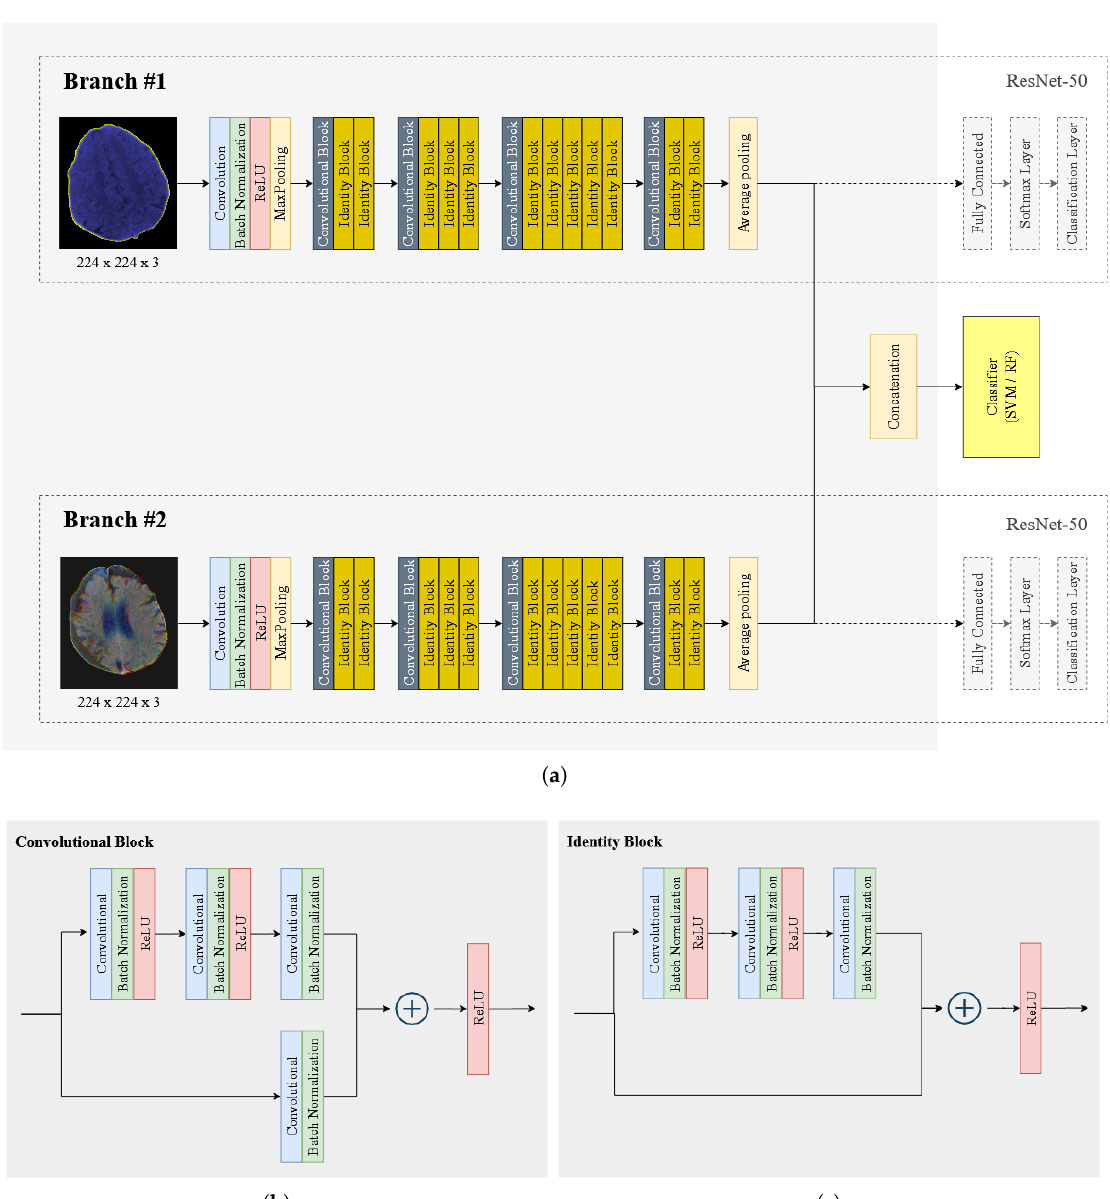
Figure 4. Illustration of the double-branch convolutional neural network (CNN) based on the ResNet-50 architecture ( a ). The feature extraction CNN is covered by a gray background. Dashed frames surround the full ResNet-50 structures. Rightmost blocks refer to the classification stage. Convolutional and identity blocks from ResNet-50 are presented in detail in ( b , c ),